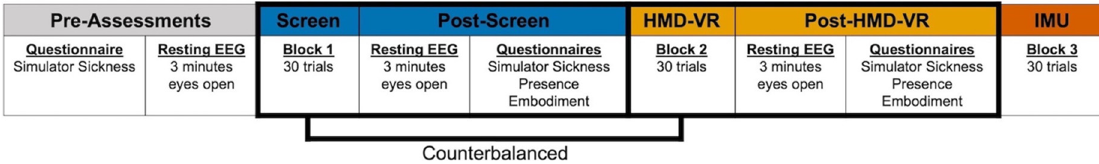
Figure 2. Experimental timeline. Prior to the experimental blocks, participants completed a questionnaire relating to simulator sickness and then completed a resting EEG recording for three minutes with eyes open. Participants then completed the three experimental blocks where the first two blocks were counterbalanced; during Blocks 1 and 2 (Screen, HMD-VR), participants were asked to think about movement in order to move their virtual arm to a virtual target arm on either a computer screen or in HMD-VR. After the Screen condition and after the HMD-VR condition, participants completed a resting EEG recording for three minutes with eyes open and then completed a series of questionnaires relating to simulator sickness, presence, and embodiment. During Block 3 (IMU), participants were asked to move their physical arm to a virtual target arm in HMD-VR, as a control condition.